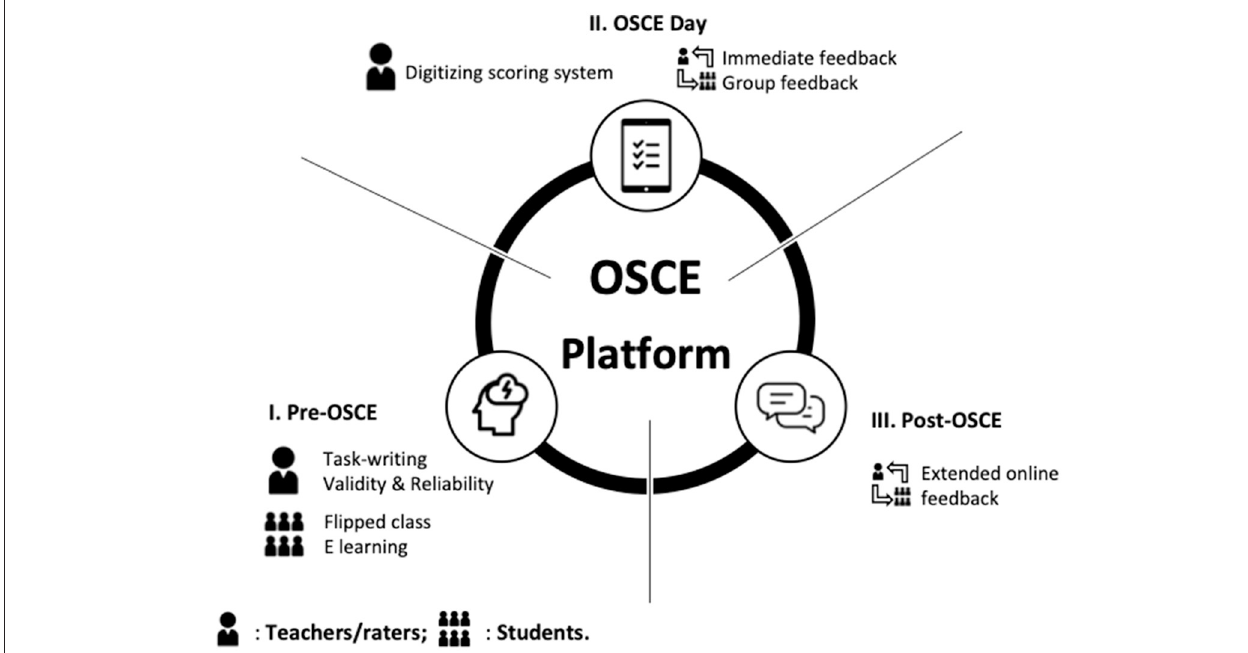
FIGURE 1 | Diagrammatic framework of Online Smart Communicative Education System. The online system comprises (I) Pre-objective structured clinical examination (OSCE): an online flipped class for preparation of task-related knowledge and skills for students, and task-writing for submission to teachers; (II) OSCE-day: 10 tasks in one track formative OSCE and a digitizing scoring system with educational support for teachers with immediate and group feedback; and (III) Post-OSCE: extended online feedback for participants with further questions after the exam and opportunities for teachers to provide more feedback following the review of their performance